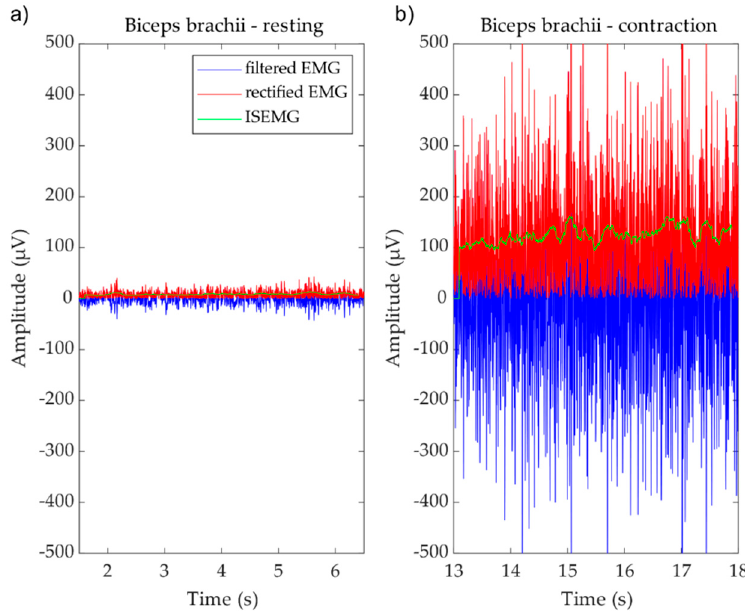
Figure 8. Example of one sEMG recording on the Biceps brachii muscle. Example of filtered (blue), rectified (red), and average smoothed sEMG (green) recording for ( a ) resting and ( b ) contraction states.